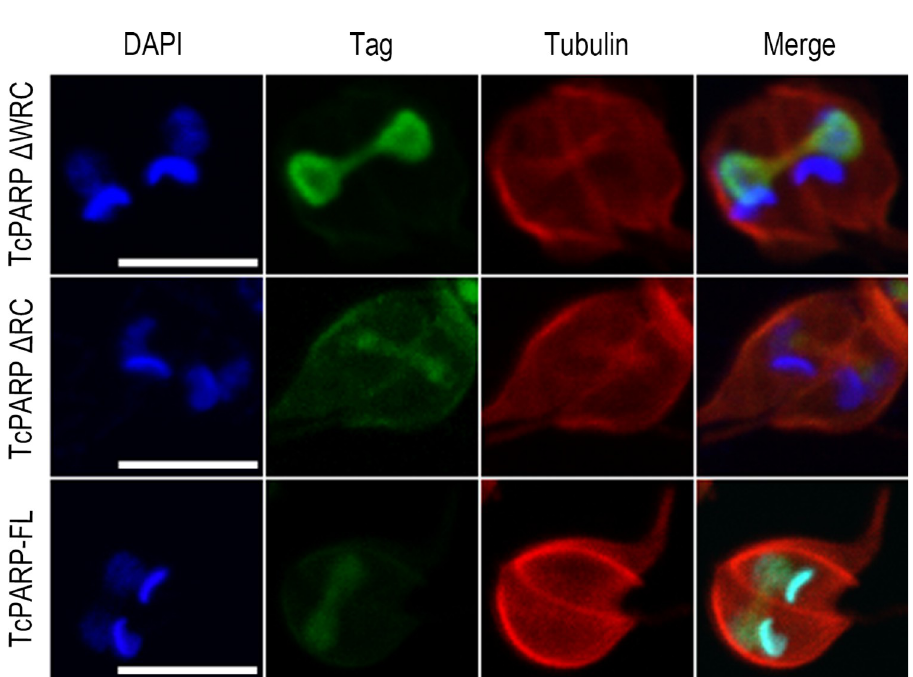
Fig 3. Colocalization of TcPARP with tubulin in the connecting thread. Indirect immunofluorescence of epimastigotes overexpressing TcPARP-FL or the N-terminal domain of TcPARP (TcPARP Δ WRC and TcPARP Δ RC). Tubulin was detected by an antibody directed against α -Tubulin and recombinant variants of TcPARP with the corresponding anti-tag antibody. Scale bar: 5 μ m.